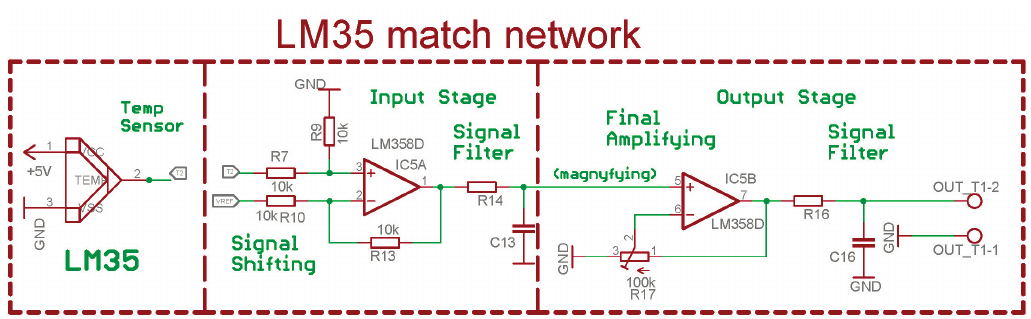
Figure 3. Input signal stage with basic signal adjustments.